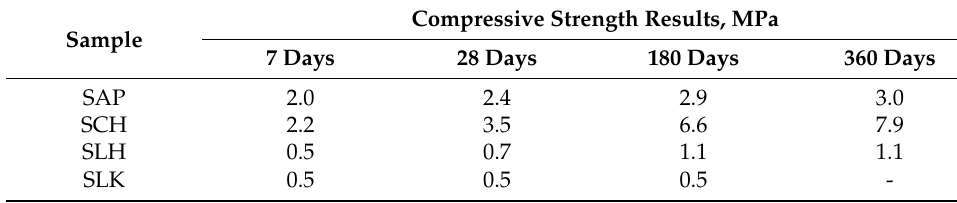
Table 6. Compressive strength of heat-treated serpentinite